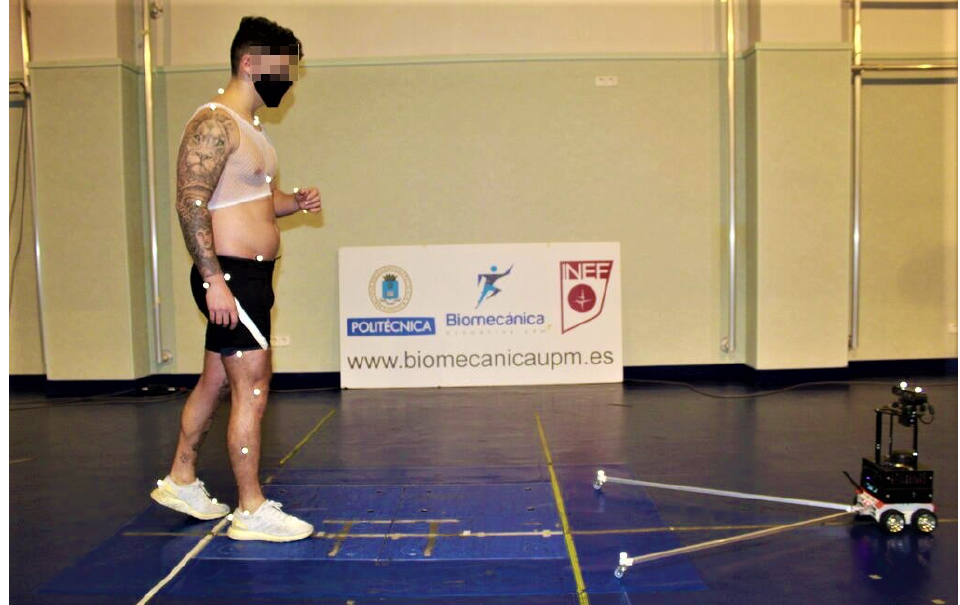
Figure 8. An overview of the experimental environment during the validation